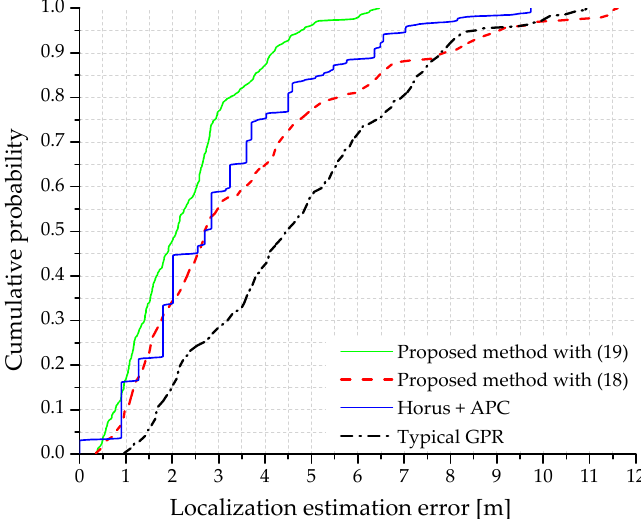
Figure 6. Cumulative probability of the localization estimation error.